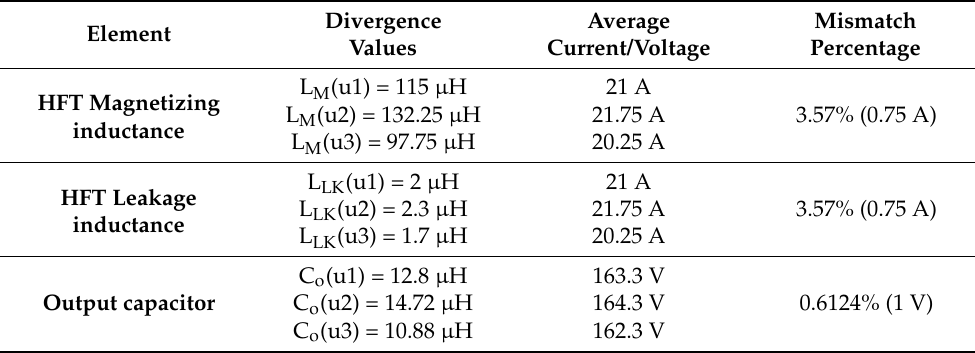
Table 6. Parameter mismatch of the proposed